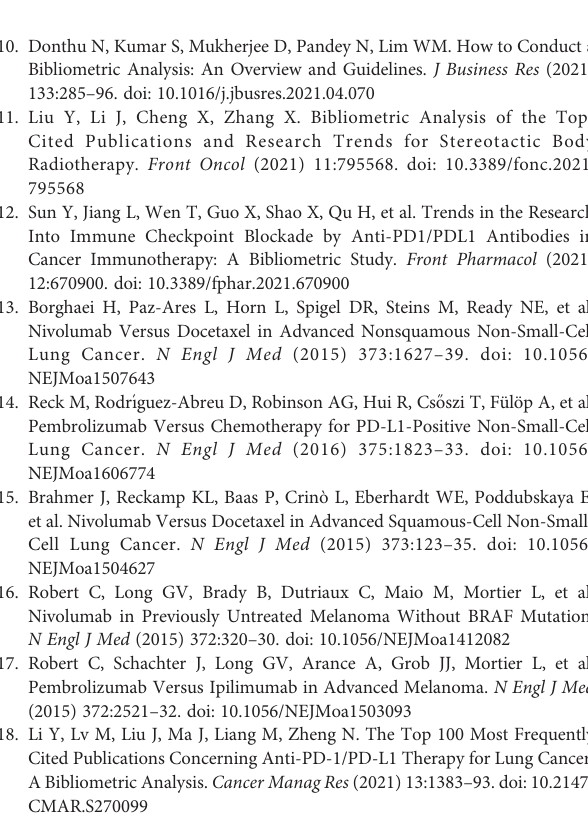
Supplementary Figure S1 | Historical direct citation network among the most cited